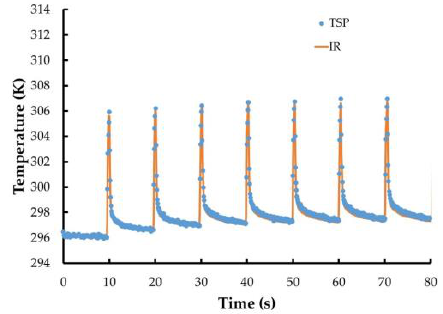
Figure 4. Temperature from TSP (points) and IR camera (line) with 115 W (50 V, 2.3 A) applied to CNT layer.